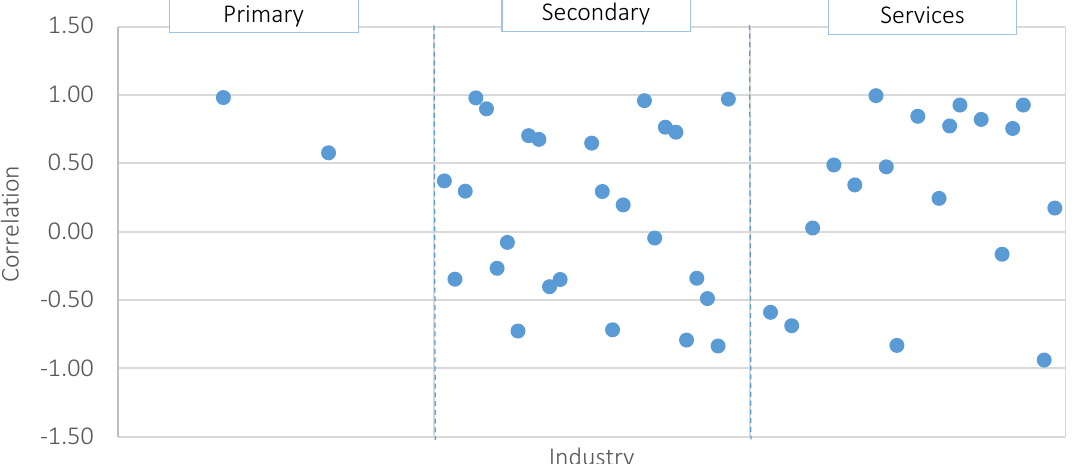
Figure 7. Correlation between product innovators’ turnover and R&D